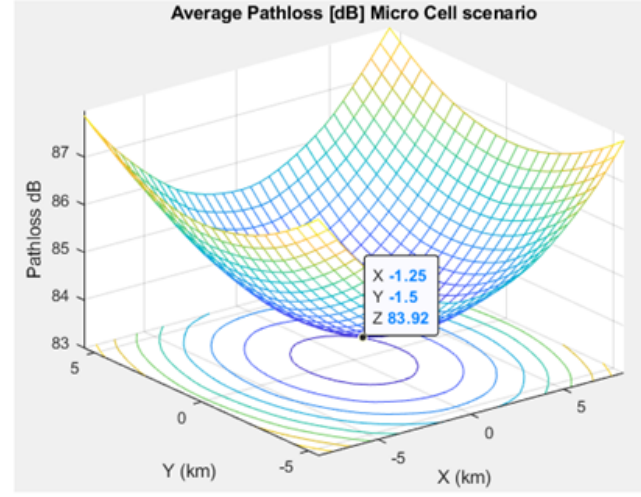
Figure 22. Average path loss in the microcell scenario.